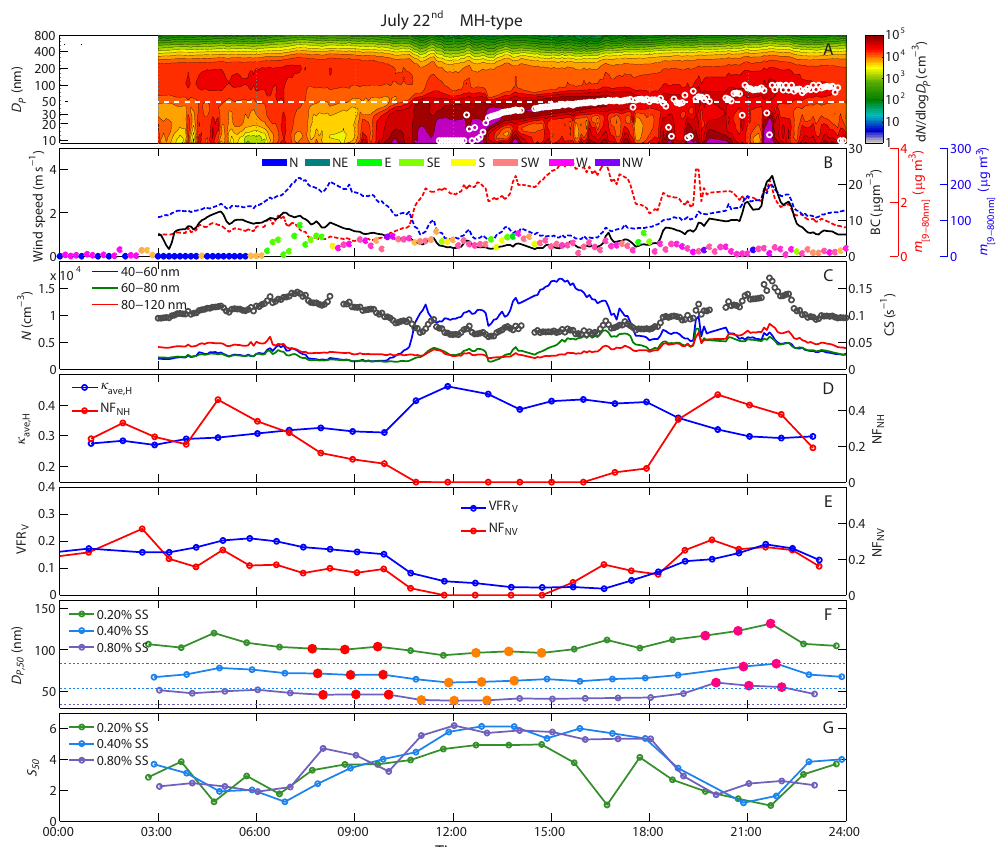
Figure 3. MH-type NPF event on 22 July. Time series of (a) particle number size distribution and geometric mean diameter of nucleation mode, (b) wind speed/direction and the mass concentration of BC, sub-80nm and sub-800nm particles, (c) condensational sink (CS) and number concentration of particles in defined size ranges, (d) average κ of hygroscopic mode and number fraction of nearly hydrophobic mode for 50nm particles, (e) volume fraction remaining of volatile mode and number fraction of non-volatile mode for 50nm particles, (f) D P , 50 for 0.20, 0.40, and 0.80% SS, as well as (g) S 50 for the three SS. The dashed lines in panel (f) show the theoretical critical diameters for ammonium sulfate at the three SS. Points filled with color in panel (g) show the records selected to calculate the average size-resolved activation ratio shown in Fig. 5.